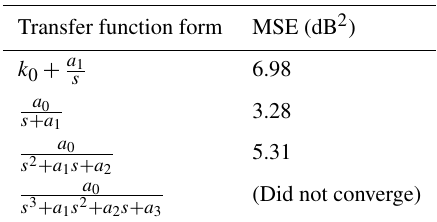
Table 3. Mean-squared error for various first-stage curve fits to raw